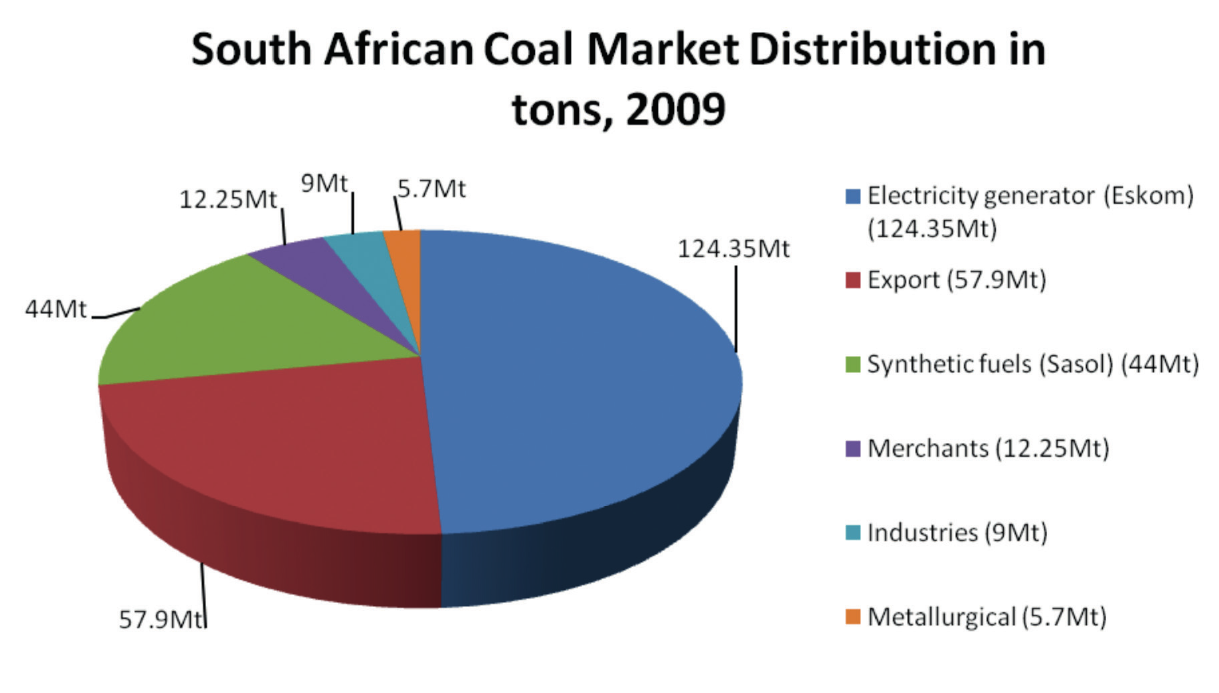
Graph 1: South African coal market distribution in tonnes, 2009 Source: (DMR,